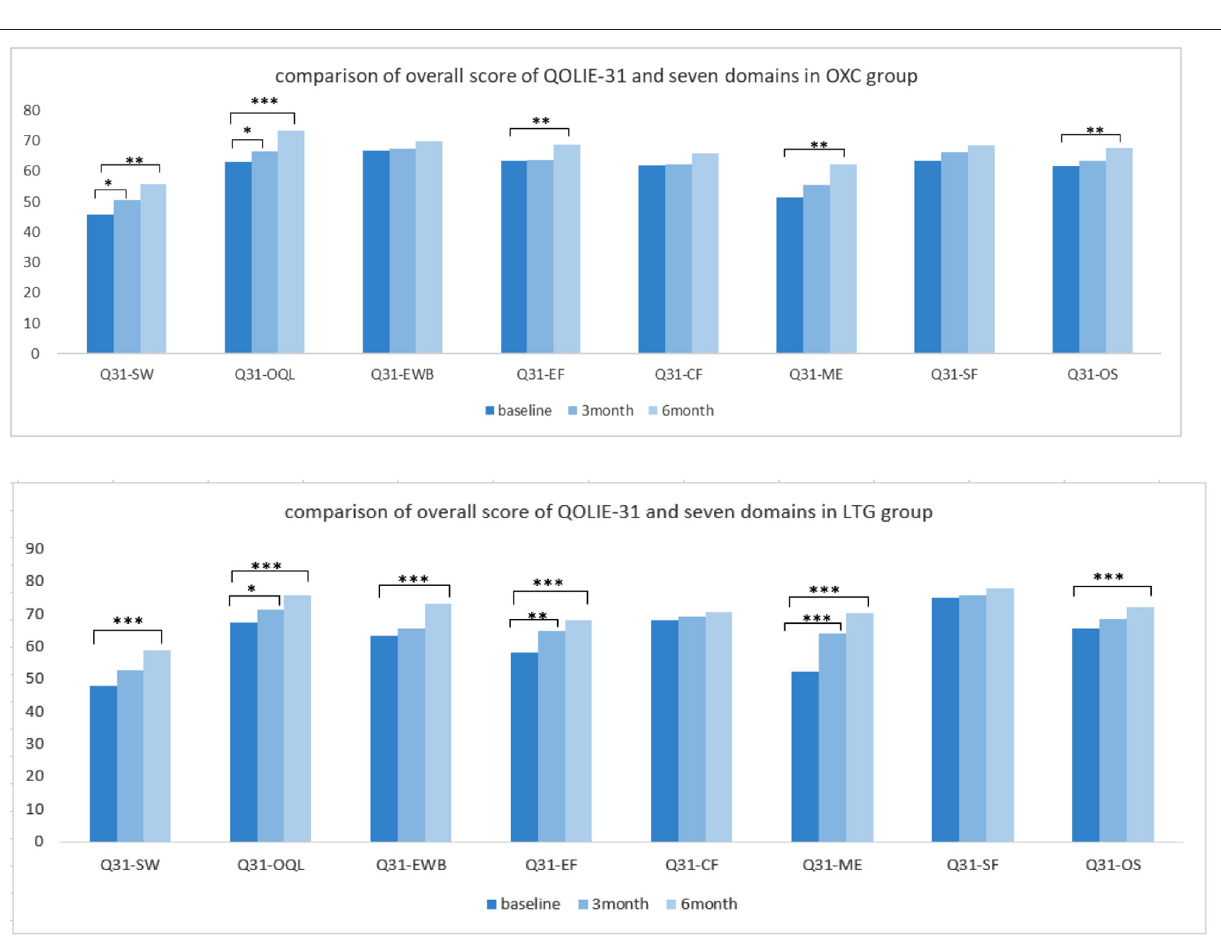
FIGURE 4 | Comparison of quality of life independently in each group. OXC, oxcabazepine; LTG, lamotrigine; Q31, QOLIE-31; SW, seizue worry; QOL, overall quality of life; EWB, emotional wellbeing; EF, energy/fatigue; CF, cognitive functioning; ME, medication effect; SF, social functioning; OS, overall score. * P < 0.05; ** P < 0.01; *** P <